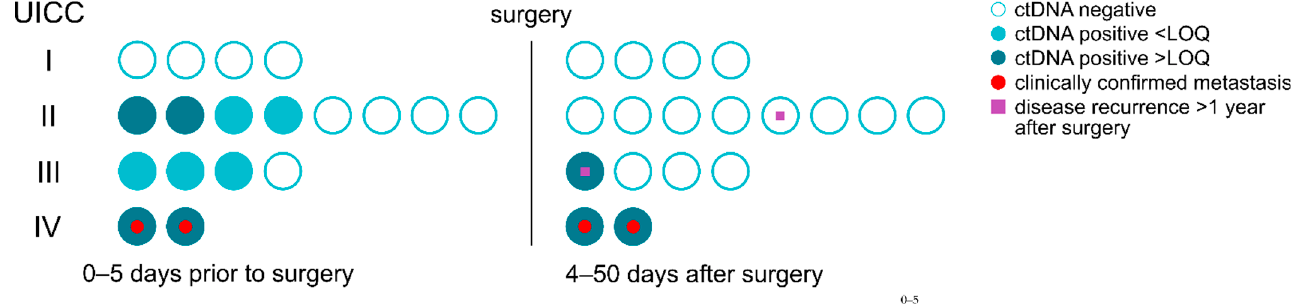
Figure 3. Determination of ctDNA positivity status in CRC stage I–IV patients for residual disease